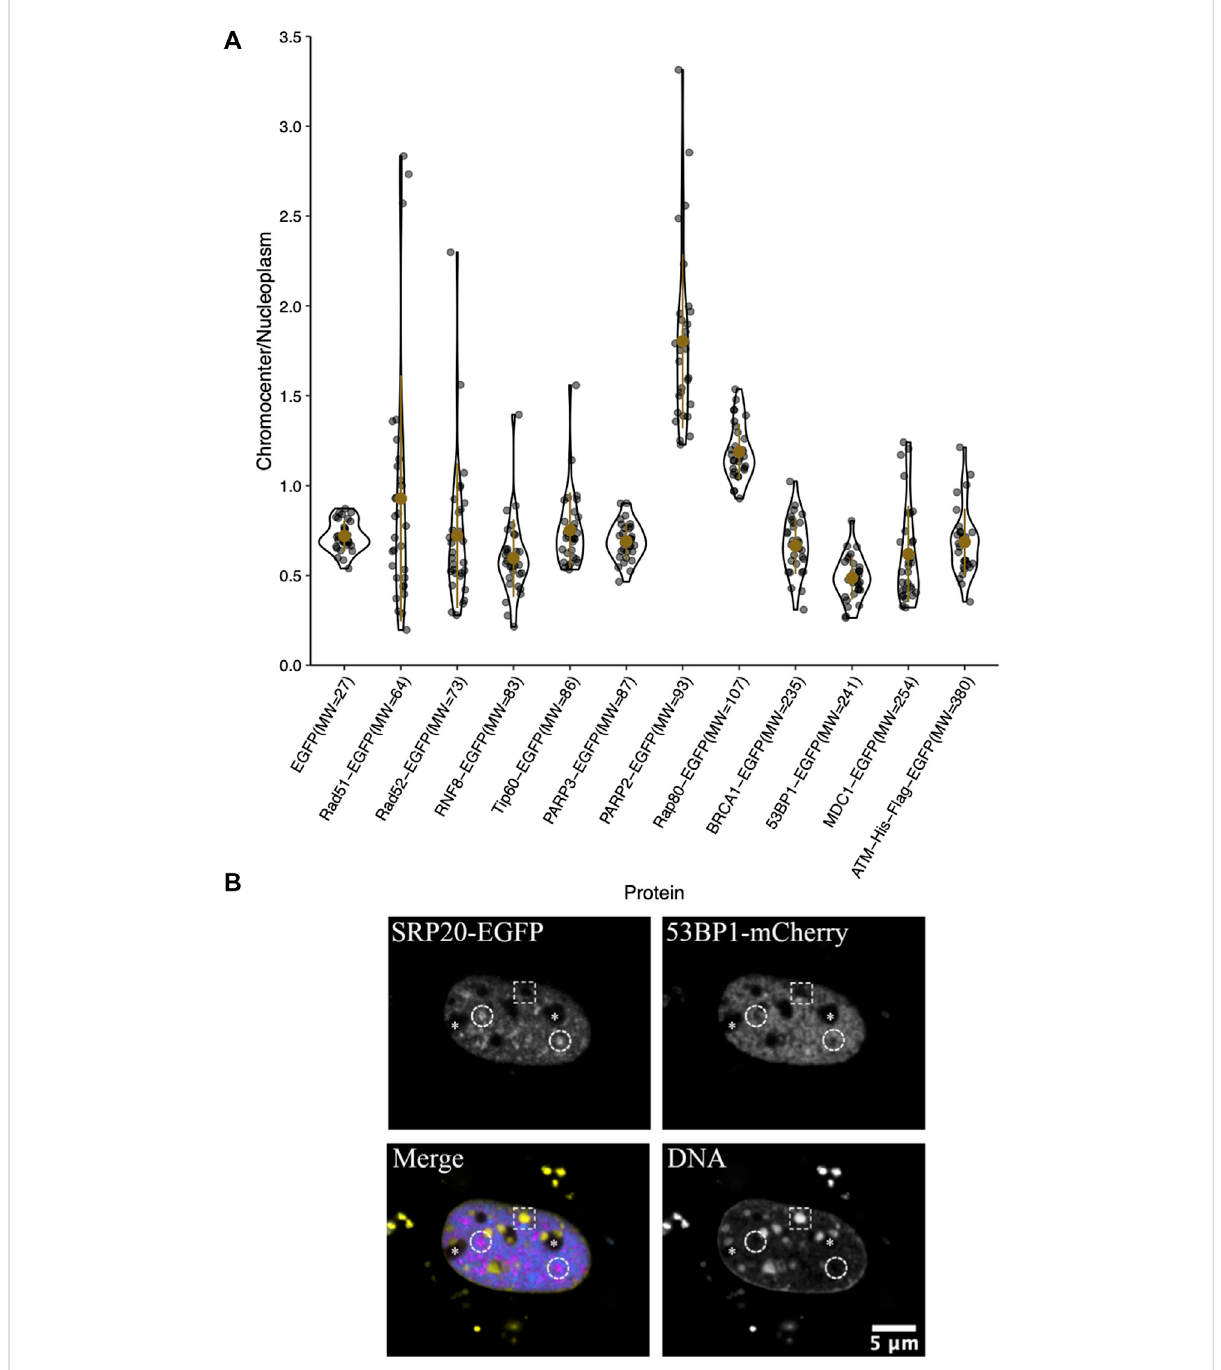
FIGURE 3 Chromocenterlocalization ofmediator and effector proteins. (A) Graph showing quanti fi cation ofrelative chromocenterintensityfor mediator and effector proteins. Cells were transfected with a plasmid encoding the protein of interest and stained with Hoechst 33342 to visualize DNA ( n = 30 for each protein). (B) A cell expressing the splicing factor SRp20-EGFP and 53BP1-mCherry and counterstained with Hoechst 33342 to contrast the chromatin. The dashed circles indicate the positions of splicing factor compartments while the dashed rectangle illustrates the position of a chromocenter. Asterisks indicate the positions of